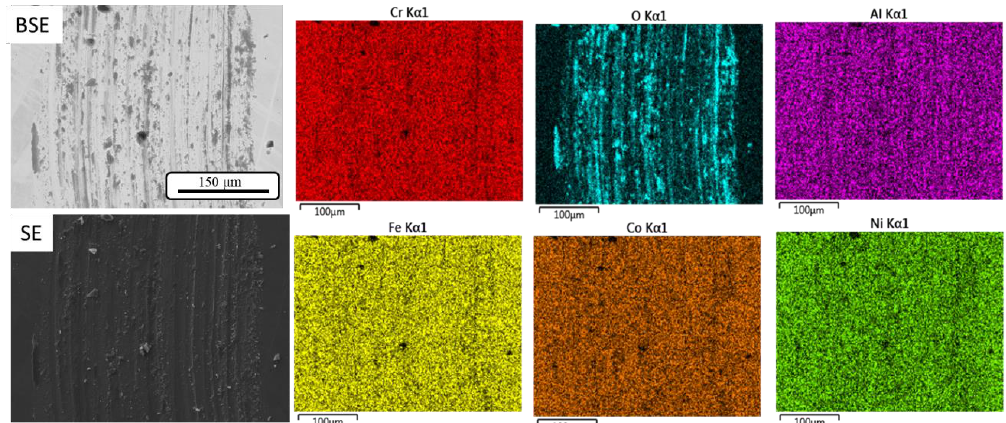
Figure 4. BSE and SE images and corresponding EDS elemental maps of the A1 alloy wear track after RT sliding.